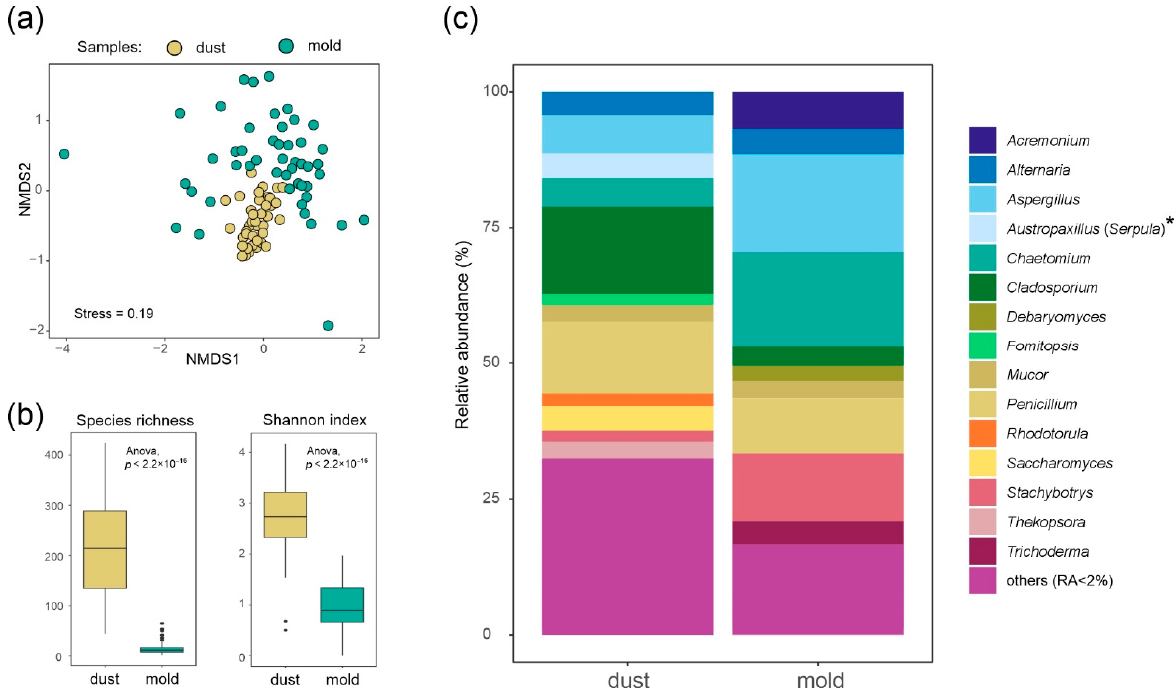
Figure 2. Comparison of dust and mold mycobiota, as revealed by DNA metabarcoding: ( a ) NMDS plot showing the differences in the fungal community composition of 42 dust samples and 48 mold samples; ( b ) variation of the alpha diversity indices; ( c ) the most abundant fungal genera (RA ≥ 2%) identified in each sample type. Note that the genus Serpula was initially misidentified as Austropaxillus in the first automatic taxonomic assignment ( * ).